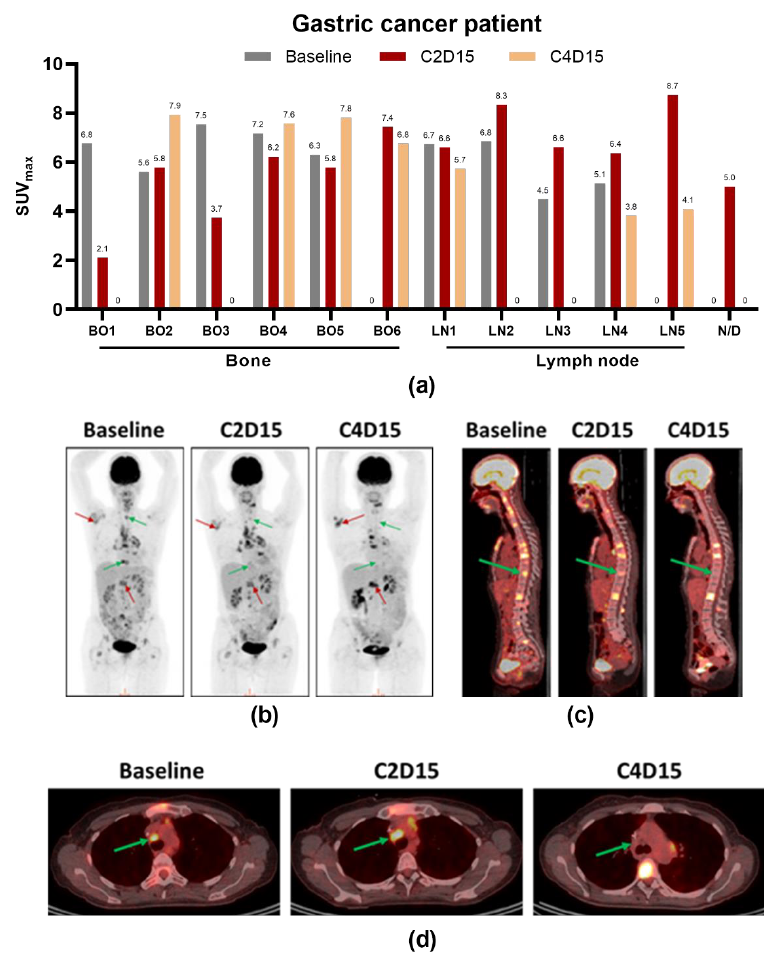
Figure 5. PET/CT scans of a MET -amplified gastric adenocarcinoma patient showing response to ARGX-111. ( a ) SUV max values at baseline, C2D15 and C4D15 grouped by lesion (BO, bone; LN, lymph node; N/D, not determined); ( b ) Representative images of 18 F-FDG uptake; ( c ) CT images in parasagittal view; ( d ) Axial view of a responding lymph node lesion at baseline, C2D15 and C4D15. Red arrows, non-responding lesions; green arrows, responding lesions.